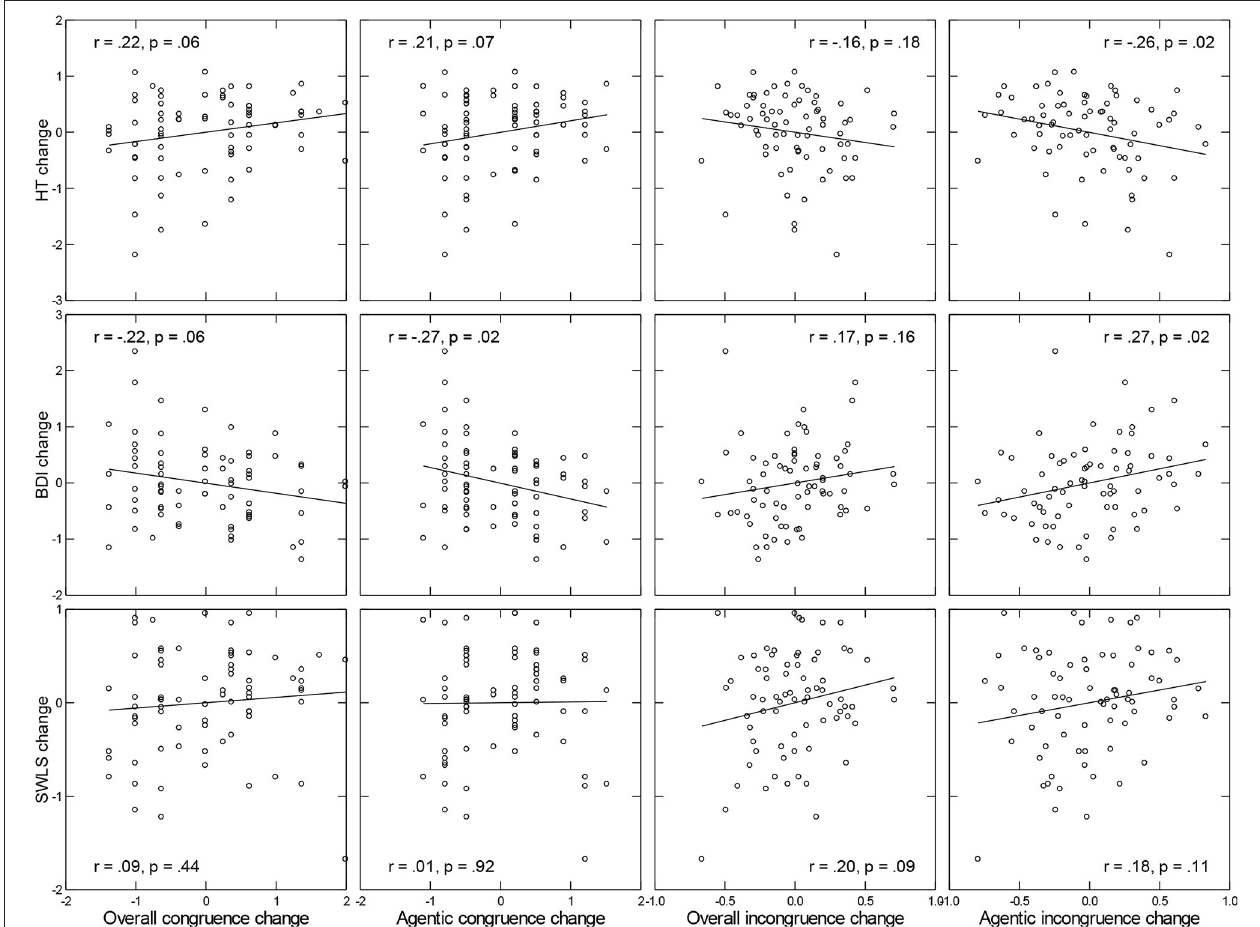
FIGURE 4 | Associations between changes in indicators of well-being (horizontal) and indicators of congruence ( Left two columns) and incongruence ( Right two columns). Coefficients provided in each panel represent bipartial